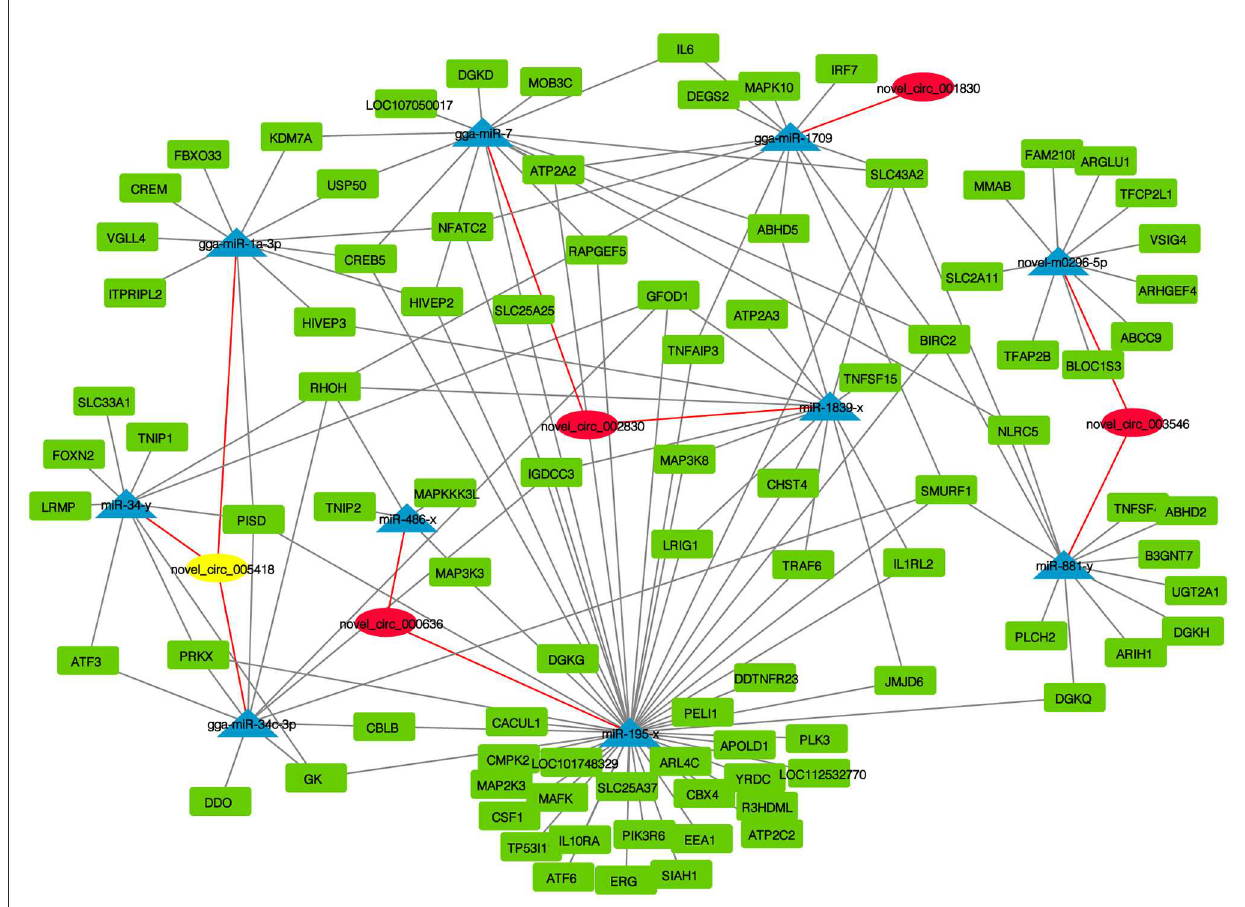
FIGURE5 CircRNA-miRNA-mRNA interaction network of significantly DE circRNAs from NDV-infected CEFs.